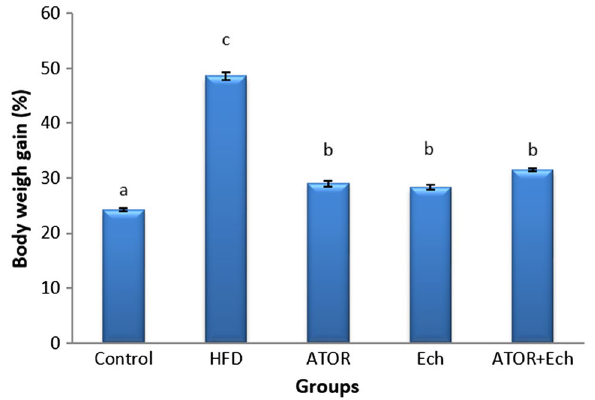
Fig. 1 Effect of Ech and ATOR on body weight gain in hyperlipi- demic rats